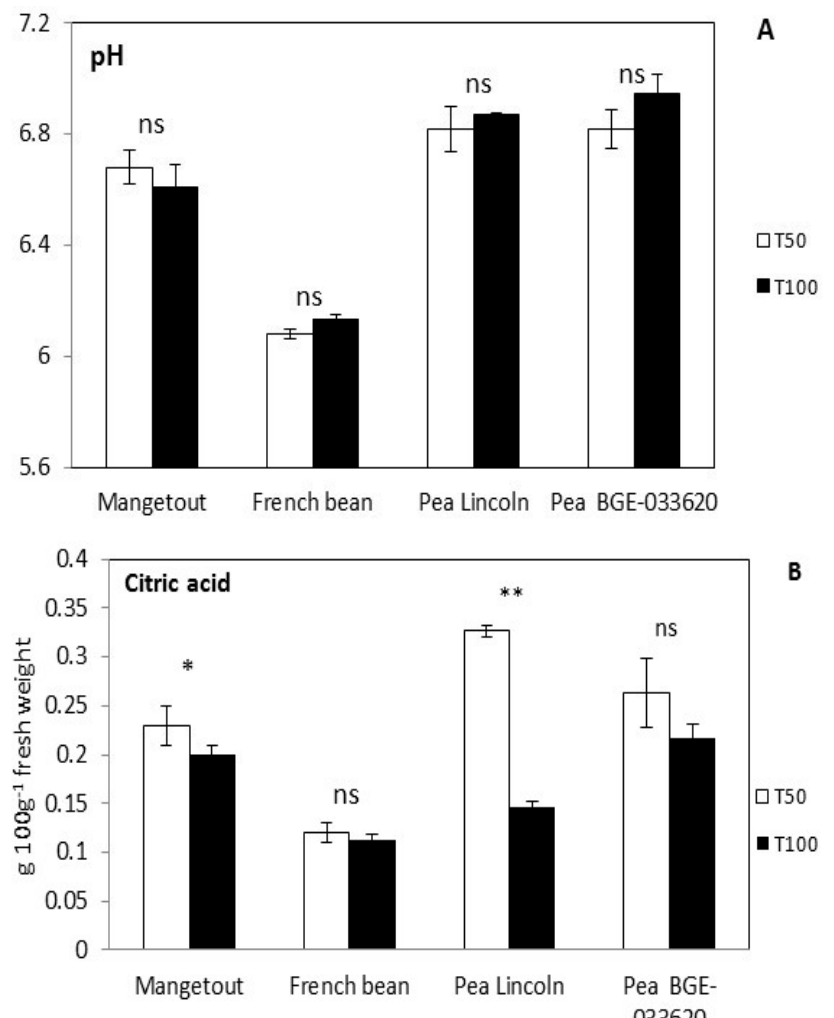
Figure 2. Total soluble solids (expressed as ° Brix) in edible parts of mangetout , French beans and peas grown under normal (T100) and sustained deficit (T50) fertigation tested under protected cultivation conditions. * and “ns” indicate significant differences at p < 0.05, and non-significant differences between treatments (T50 and T100) for each cultivar, respectively (ANOVA followed by Tukey’s multiple range test).